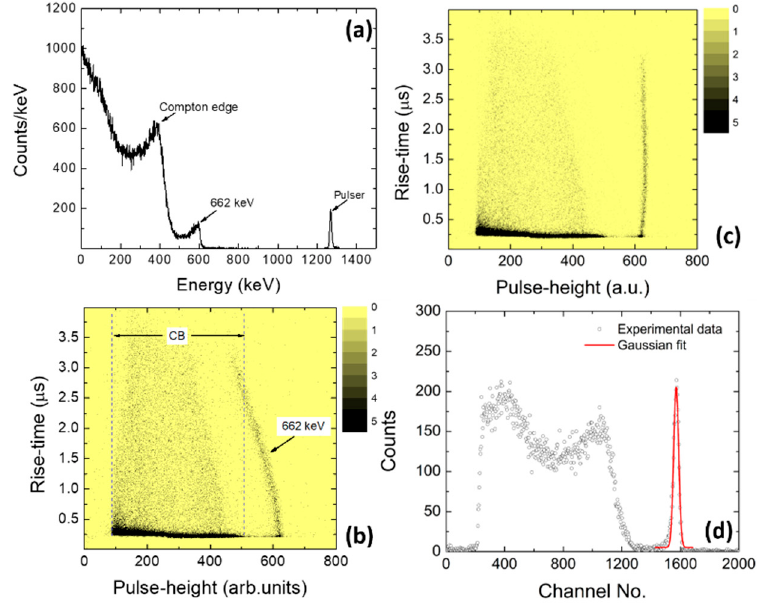
Figure 17. ( a ) 137 Cs gamma-ray PHS obtained from an as-fabricated VBM grown Cd 0.9 Zn 0.1 Te 0.97 Se 0.03 planar detector. ( b ) The corresponding biparametric correlation plot. ( c ) The corrected biparametric plot using a digital correction scheme. ( d ) The corrected PHS regenerated from the corrected bipar- ametric plot (Adapted with permission from ref. [21]. Copyright 2020, AIP